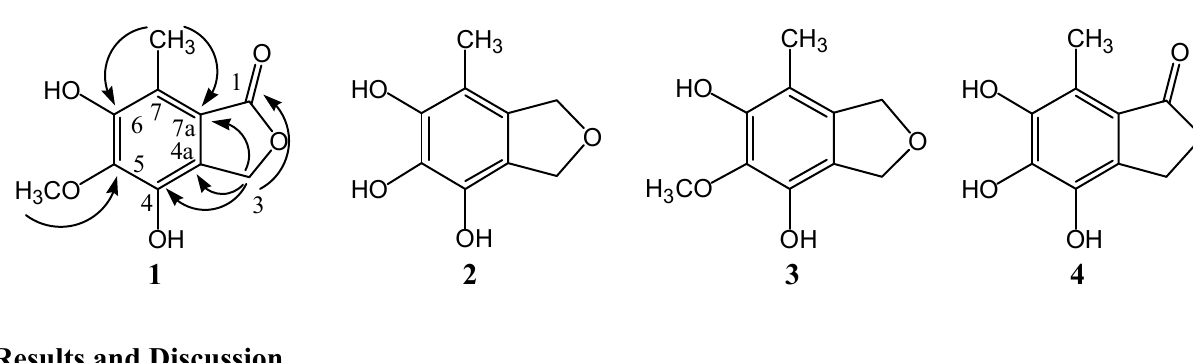
Figure 1. The structures and key HMBC correlations of compounds 1 – 4